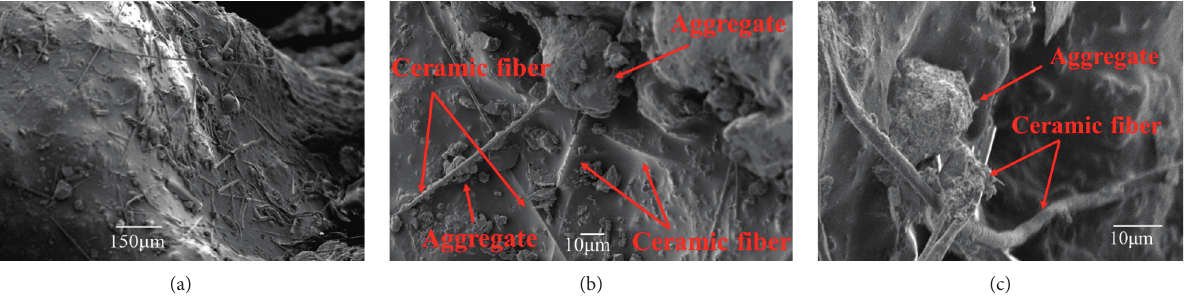
Figure 13: Three-dimensional network structure of ceramic fibers.